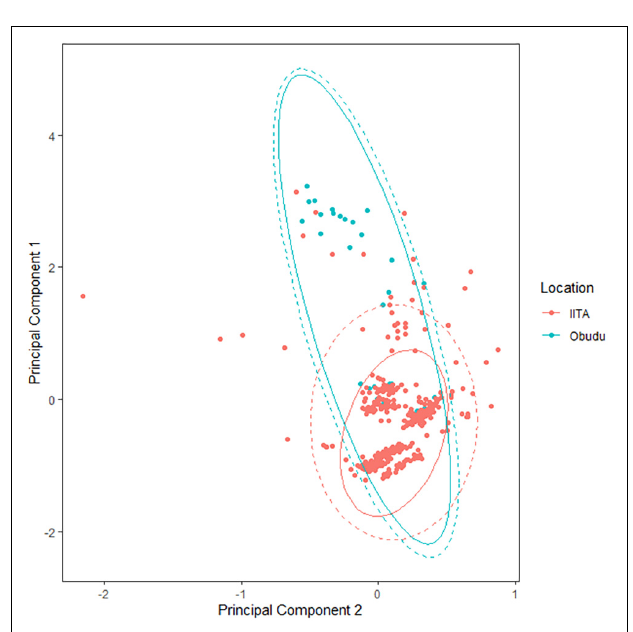
FIGURE 2 | Plots of principal component 1 vs. principal component 2 of lowland and montane species of southern guinea forest of